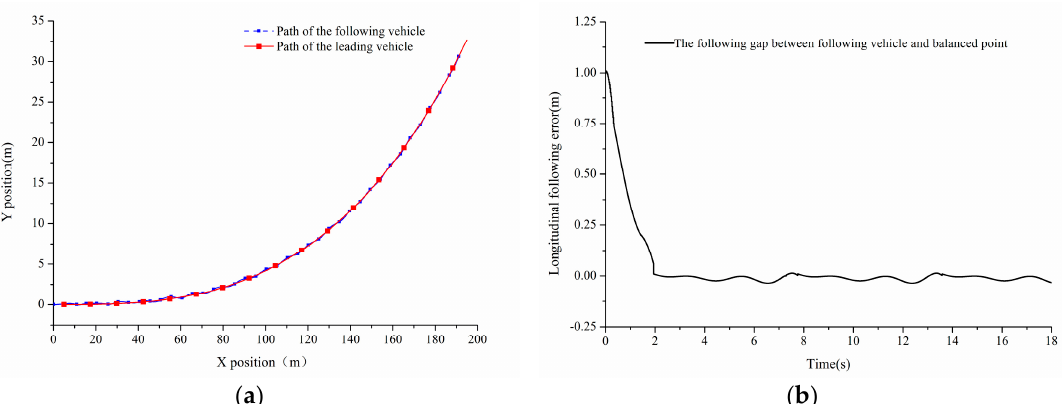
Figure 14. Tracking performance in curved road: ( a ) The path of the vehicles; and, ( b ) The longitudinal following error.